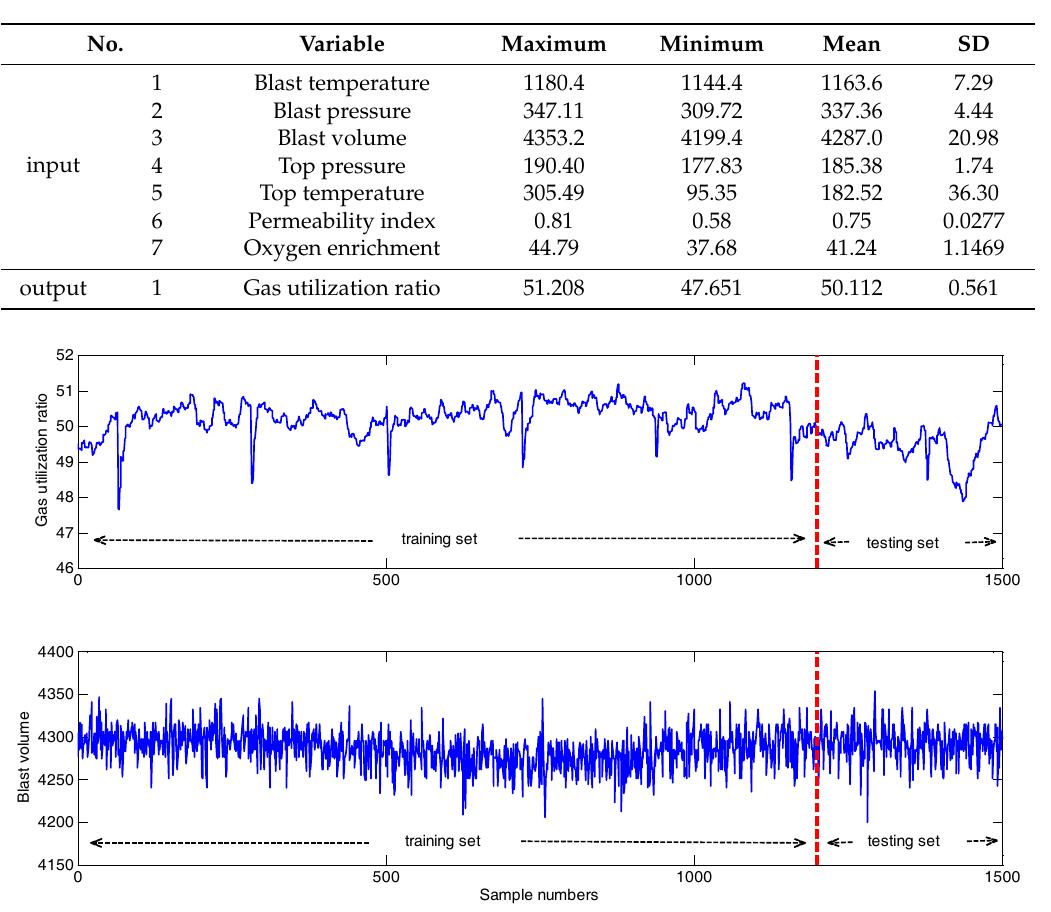
Table 3. Statistical properties of the variables.